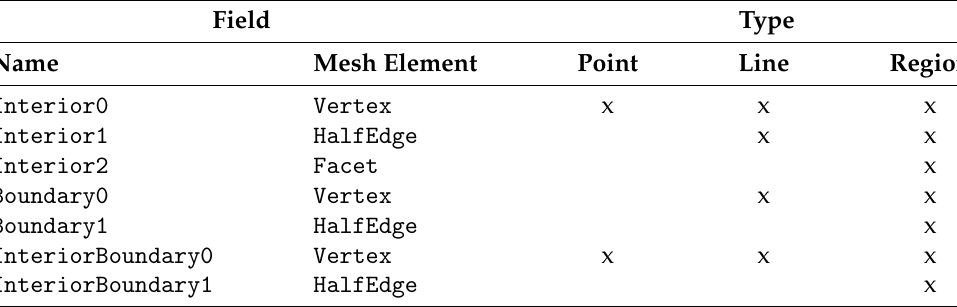
Table 3. Used fields (marked with an “x”) of Point , Line and Region types. Field